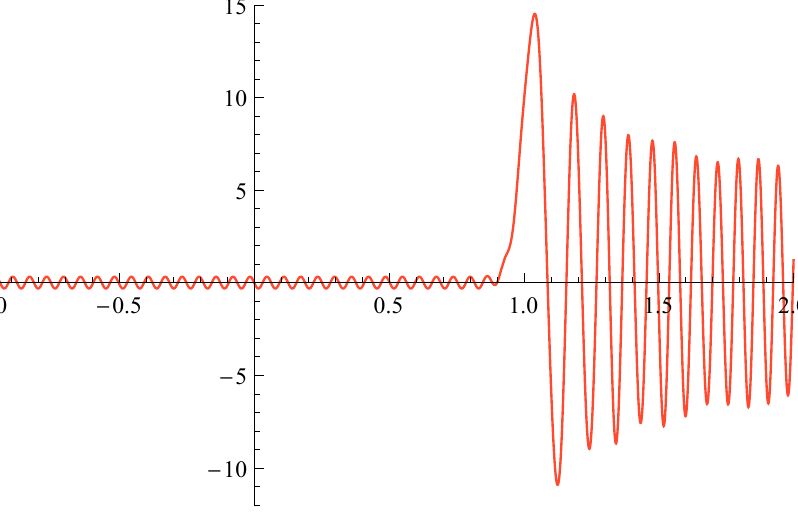
( (cid:24); (cid:17) ) versus (cid:24) at N = 100 and (cid:17) = 1. Figure 3 . Plot of J (0) (cid:1) G